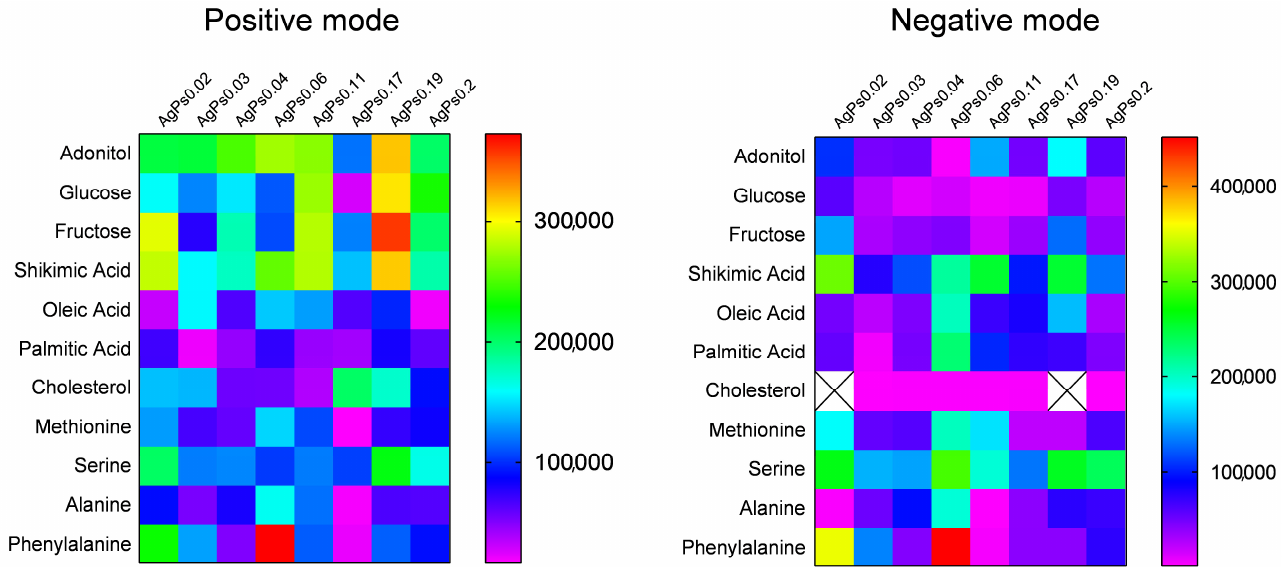
Figure 3. LDI-MS performances of the LDI-MS plates with various masses of silver for the analysis of low molecular weight compounds; molecular ions for all the compounds in positive mode were assigned as [ M+ 107 Ag ] (cid:2878) .